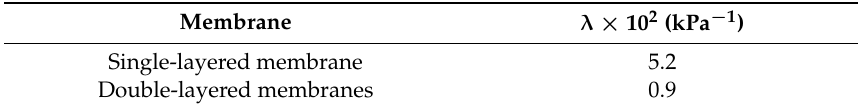
Figure 5. Comparative parameters ( α v , β kz ) for single and double-layered membranes. Permeate pressure: 108.2 kPa and temperature: 25 °C. Table 2. Comparative parameter ( λ = α v / β kz ) for single-layered and double-layered tubing membranes.